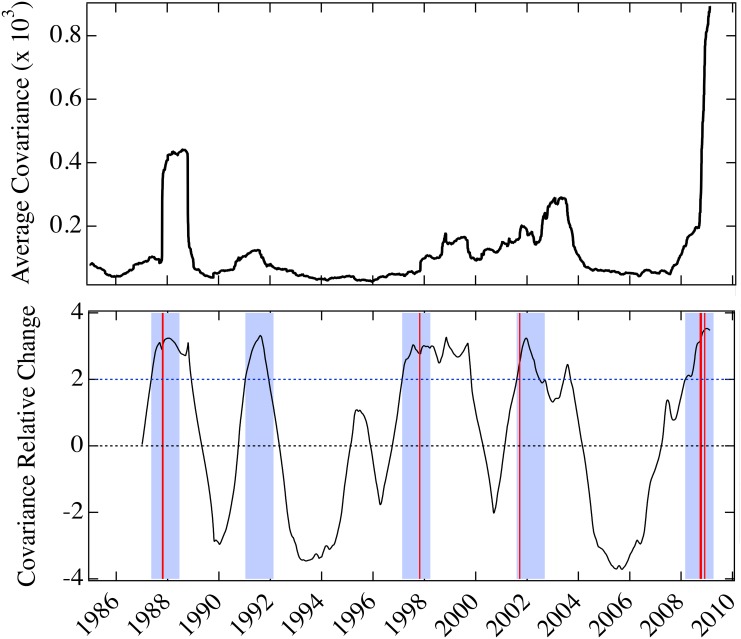
Annual relative change in covariance for the period 1985–2010.Top panel is the average covariance between price returns of the underlying components of the S&P 500 index, from 1985 to 2010. Bottom panel is the annual change of the average covariance as a fraction of its standard deviation computed over the previous year. Four year-long windows (shading) follow two standard deviation increases in the average covariance greater than twice the standard deviation from one year earlier, after periods of decline. One day crashes are as in Fig 3 (vertical red lines). This indicator yields 4 true positives and 1 false positive.